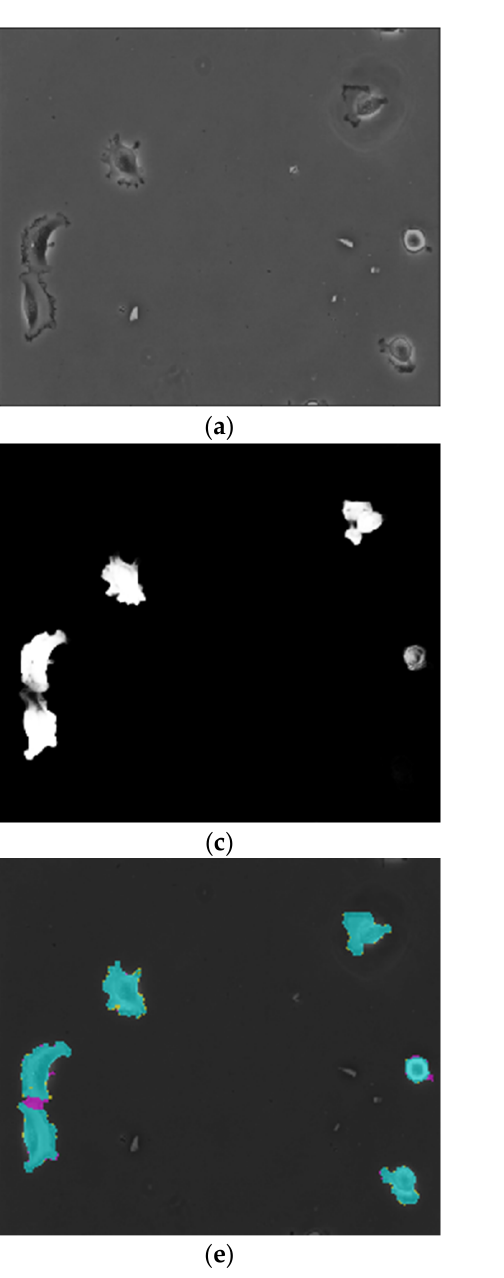
Figure 8. Comparison of objective confusion matrix results for sample M.O. detection: ( a ) original test M.O.s and ( b ) ground truth, ( c ) extracted M.O.s for U ‐ Net(4), ( d ) confusion matrix overlay mask for U ‐ Net(4), ( e ) confusion matrix overlay mask for AID ‐ U ‐ Net (3, 1), and ( f ) confusion matrix overlay mask for AID ‐ U ‐ Net (2, 2) ( ■ (cyan): as TP pixels, ■ (magenta): as FP pixels, ■ (yellow): as FNs, and ■ (black) as TNs).